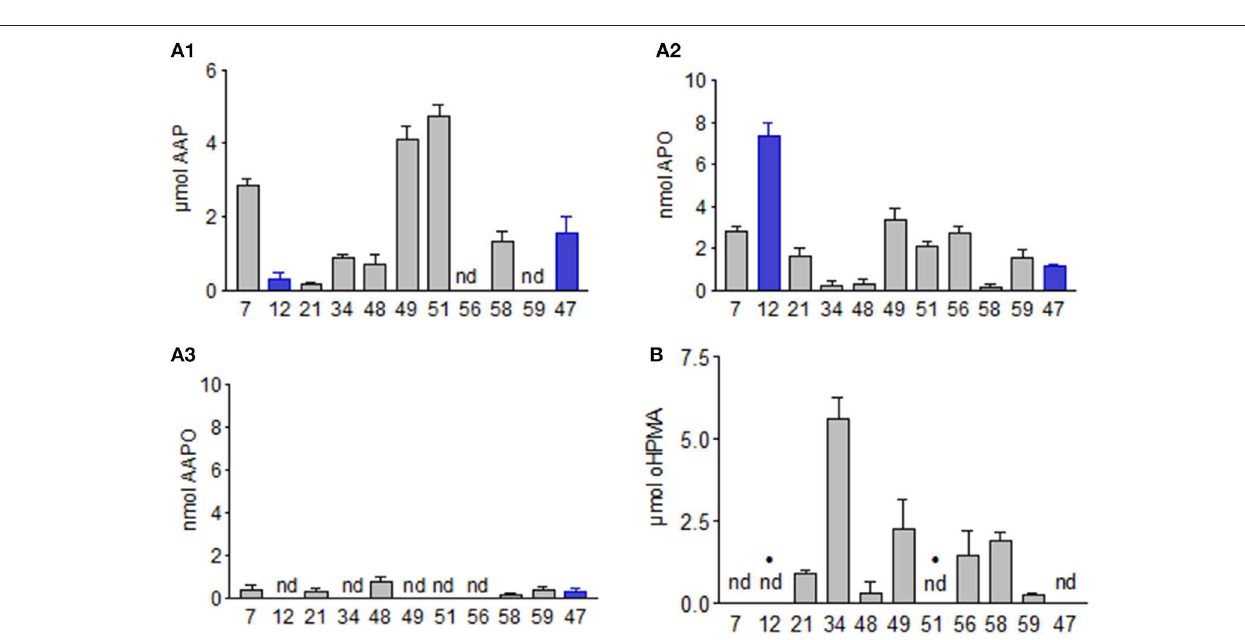
FIGURE 10 | (A1) AAP, (A2) APO, and (A3) AAPO production of the microorganisms when incubated for 72h with 7.5 µ mol AP. (B) Residual oHPMA after incubation with 7.5 µ mol, with and without accumulation of AAP (dots). Microorganisms: Mycobacterium fortuitum (7), Bacillus aryabhattai (34), Bacillus cereus (59), Bacillus megaterium (21, 48), Bacillus methylotrophicus (58), Lysinibacillus xylanilyticus (56), Paenibacillus polymyxa (51), Aminobacter aminovorans (49), the fungi Papulaspora sepedonioides (12), and Trichoderma viride (47) . Blue bars, fungi; gray bars, bacteria.